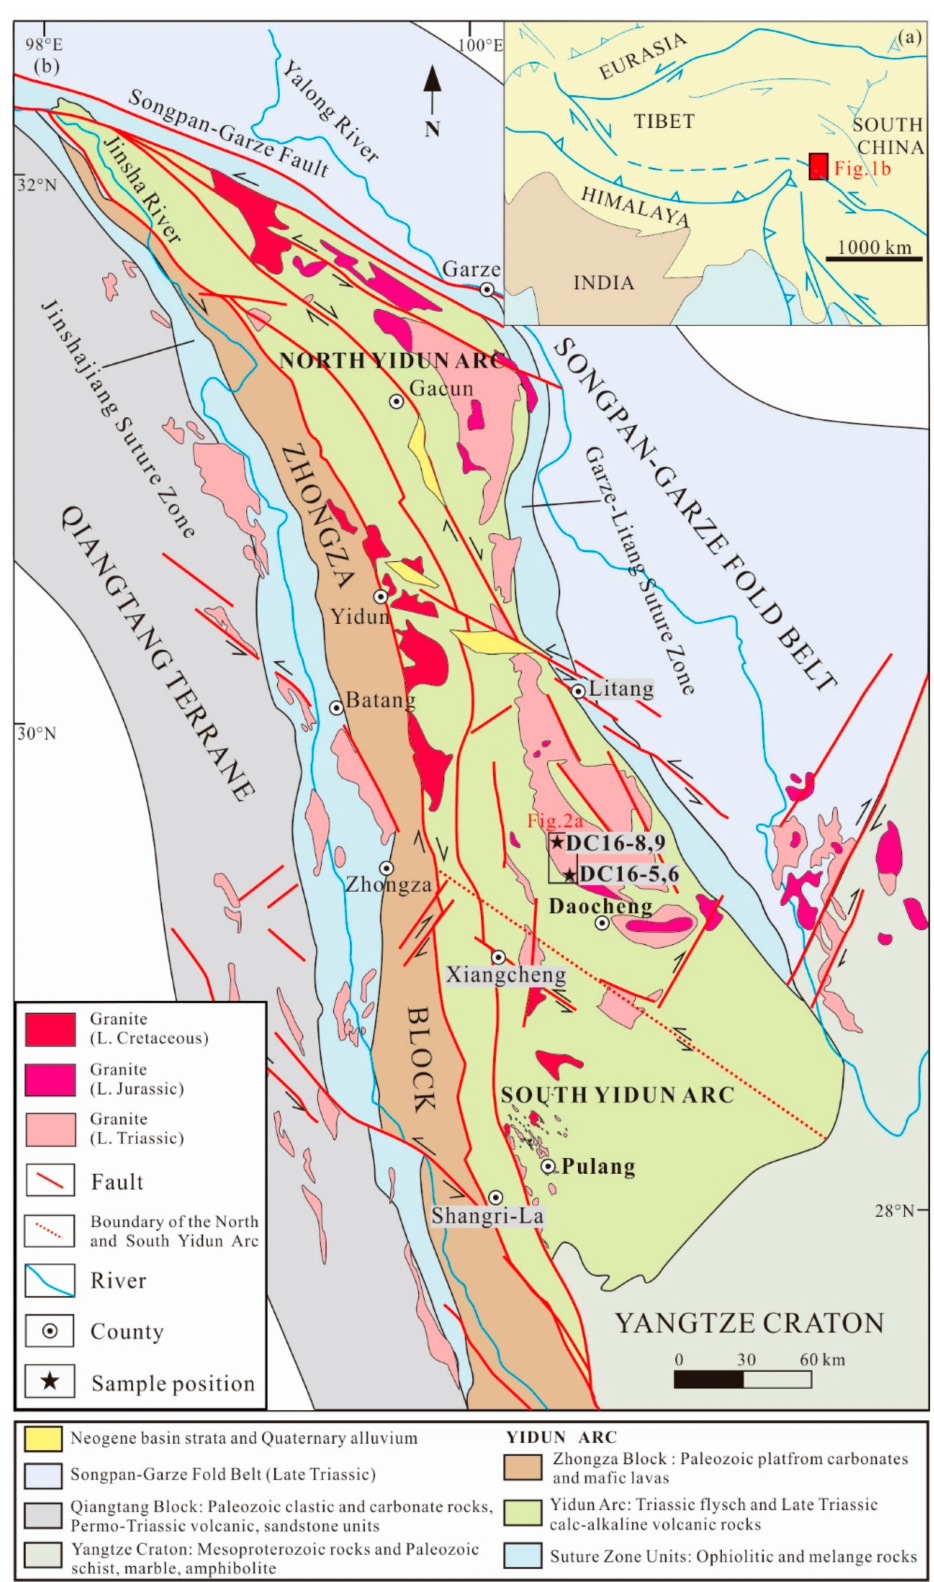
Figure 1. ( a ) tectonic outline of the Yidun Arc, showing the study area, and ( b ) simplified geological map of the Yidun Arc (modified after